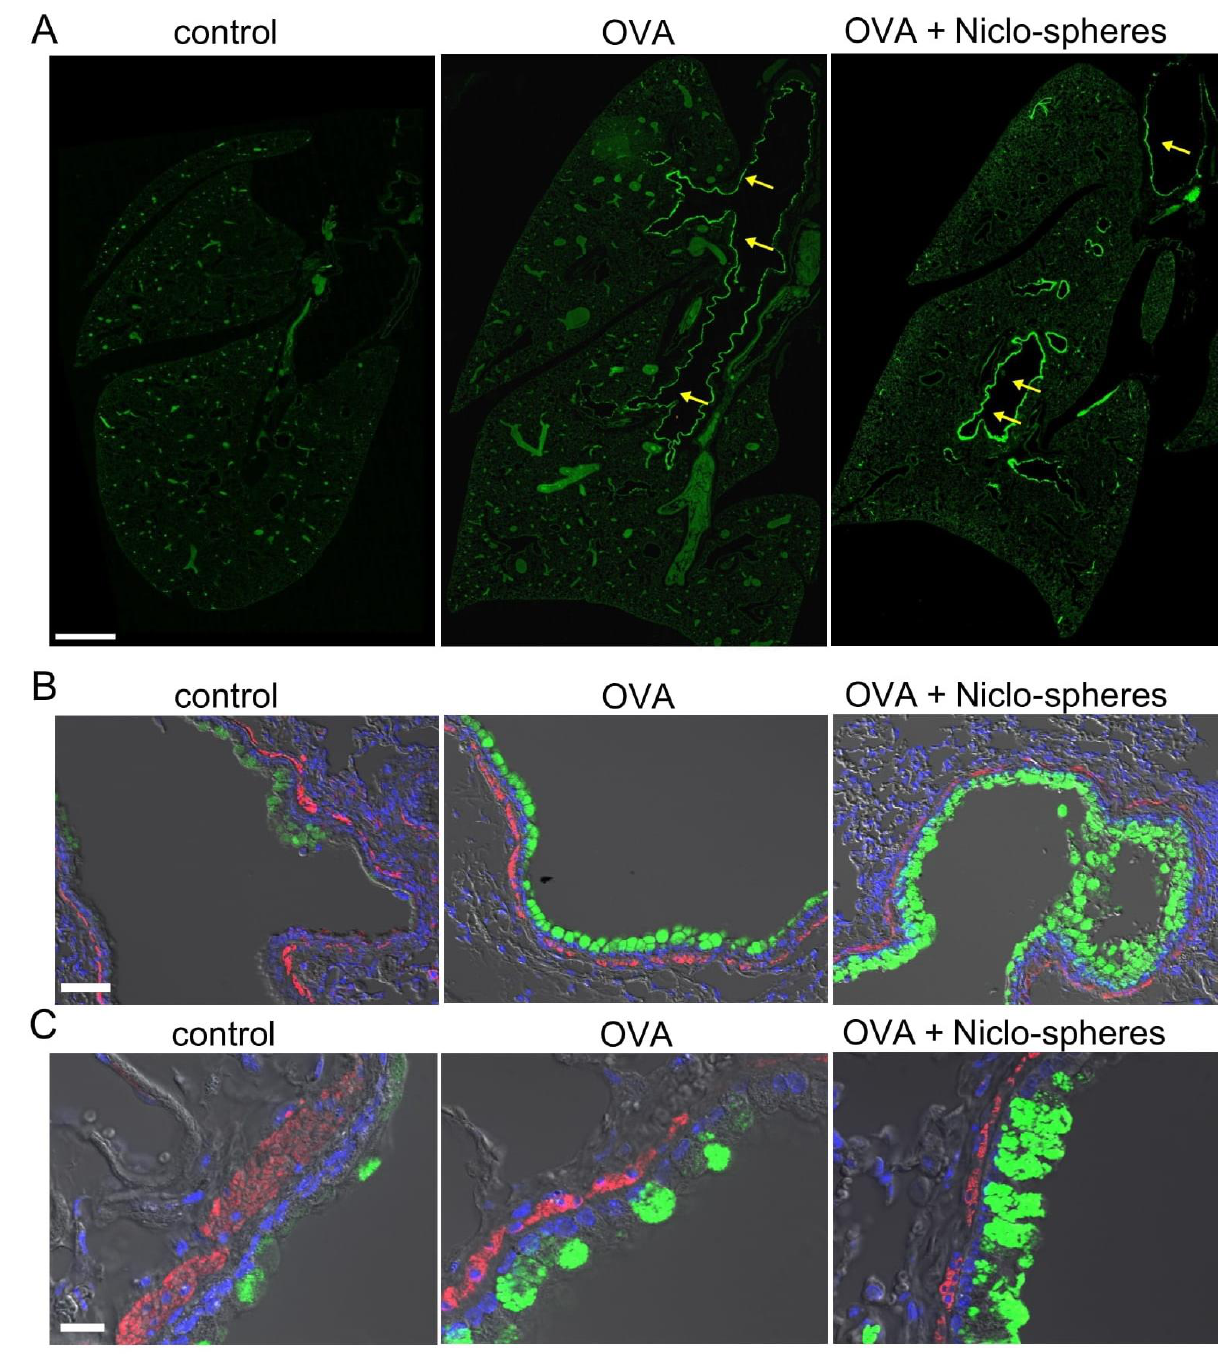
Figure 2. Accumulation of mCLCA1 in club cells by treatment with Niclo-spheres . ( A ) Whole mouse lung immunofluorescence obtained by stitching microscopy. mCLCA1 is expressed particularly in larger bronchi (yellow arrows), but not in small bronchioles and the peripheral lung tissue of asthmatic (ovalbumin (OVA)-treated) mice, and OVA-mice treated with Niclo-spheres. Intratracheal instillation of niclosamide (Niclo)-loaded spheres (Niclo-spheres; 0.196 mg; 30 µ M/5 days) induced additional accumulation of mCLCA1 in club cells. Bar = 1 mm. ( B , C ) mCLCA1 (green) and smooth muscle α -actin (red) at lower ( B ; bar = 50 µ m) and higher ( C ; bar = 20 µ m) magnification. Nuclei staining by DAPI (blue). Low expression of mCLCA1 under control conditions is upregulated in OVA-treated mice. Further accumulation of CLCA1 is observed in club cells from mice treated with Niclo-spheres; 2–3 animals for each